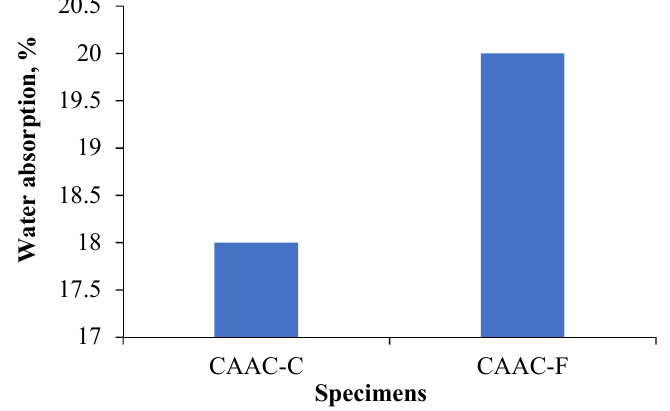
Figure 16. Water absorption of conventional AAC.